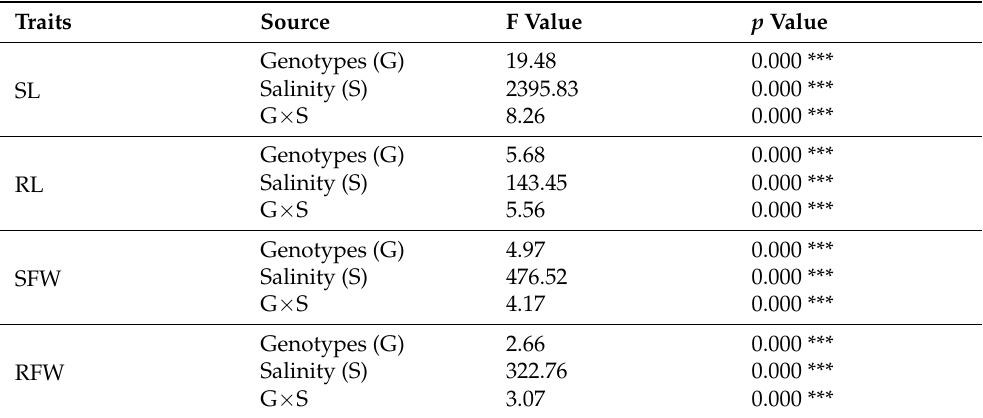
Table 3. Analysis of variance (F and p values) for the effects of genotypes, salinity, and their interaction on shoot length (SL), root length (RL), shoot fresh weight (SFW), and root fresh weight (RFW) of seedling after 21 days from sowing. Traits Source F Value p Value Genotypes (G) 19.48 0.000 *** Salinity (S) 2395.83 SL Genotypes (G)